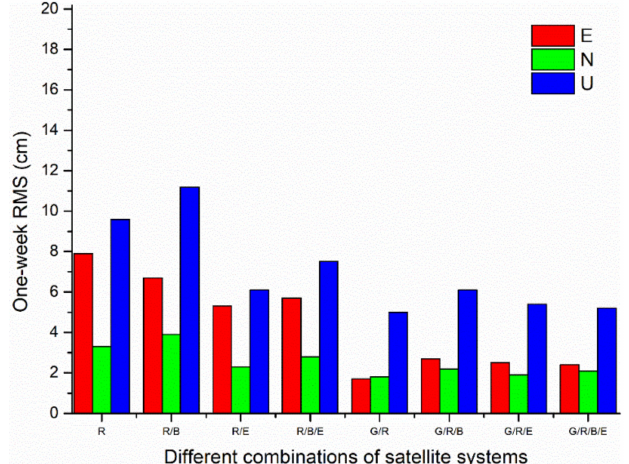
Figure 8. Positioning accuracy of different combined solutions for the LF model in kinematic mode.